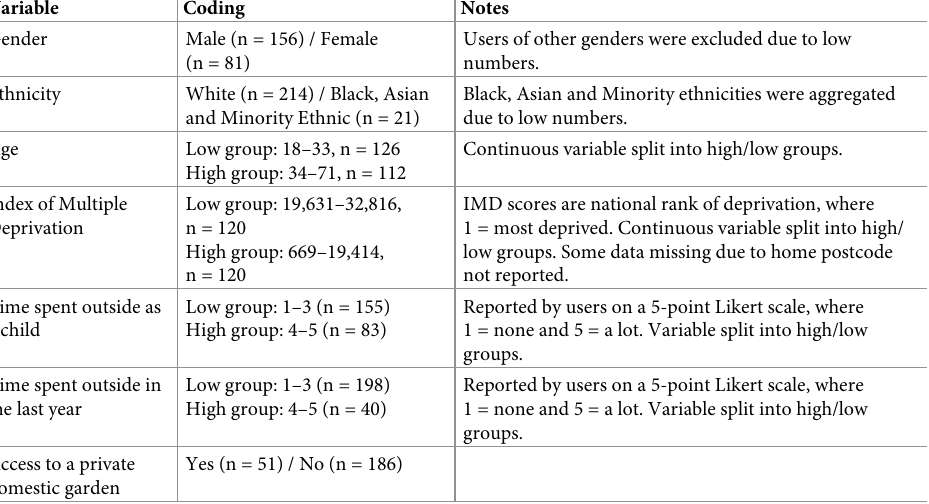
Table 3. Coding of demographic and personal variables tested for associations with trip-level characteristics of visits to greenspace. Variable Coding